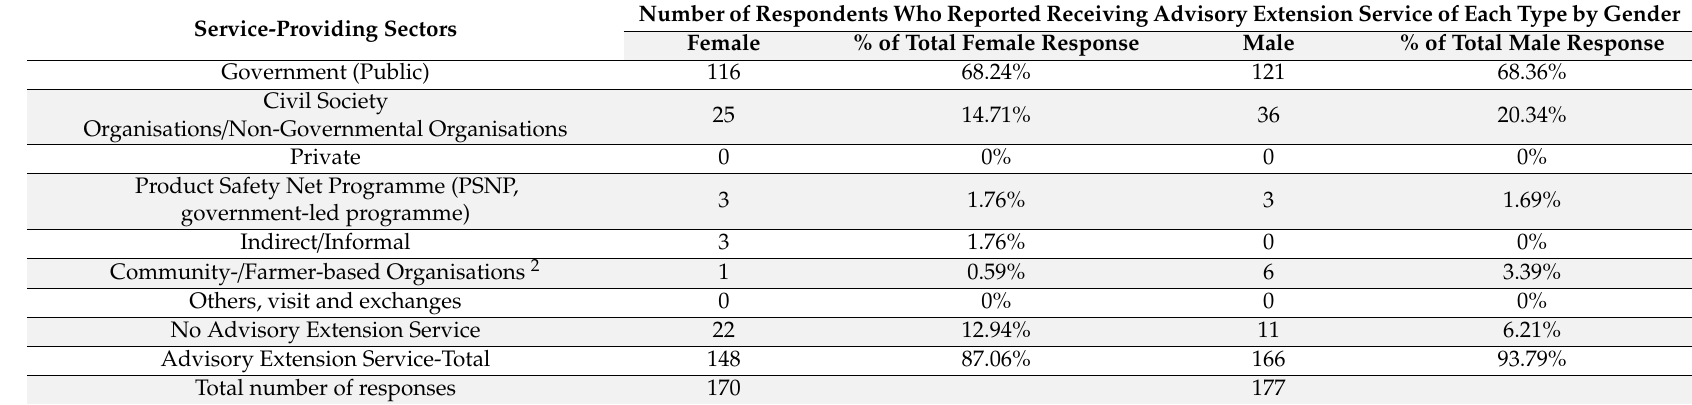
Table 3. Types of Advisory Extension Service received 1 by Smallholder Farmers (Questionnaire Survey). Responses categorised by Gender.